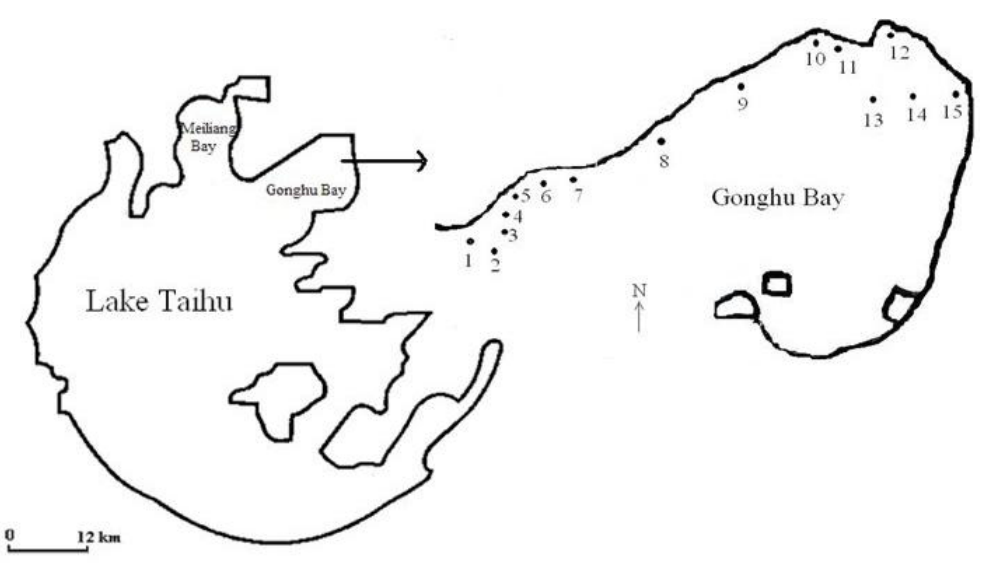
FIGURE 1. Sketch map of Gonghu Bay and the sampling